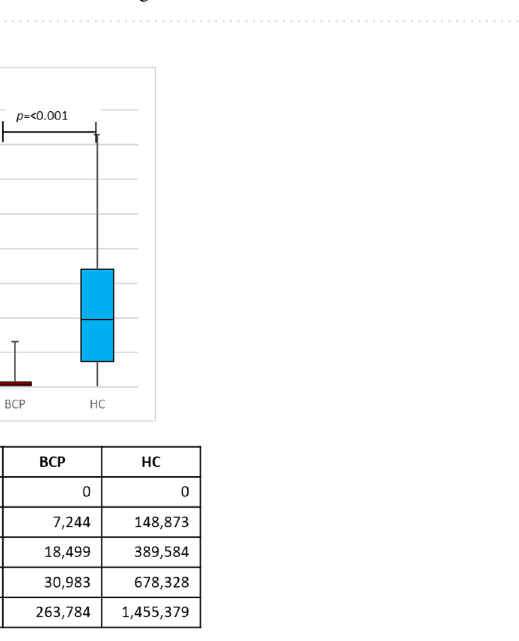
Figure 1. A representative GCMS total ion chromatograms (TIC) of urine volatile organic compounds. TIC of volatile organic compounds from urine samples collected from a breast cancer patient ( A ) and healthy control ( B ). Both samples showed various peaks. TIC total ion chromatogram.